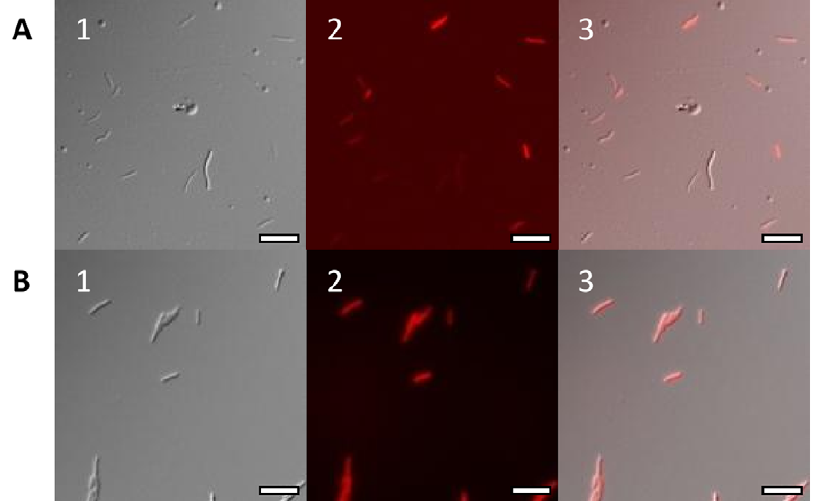
Figure 4. Microscopy of M.smegmatis mc 2 155 strains expressing mCherry. M. smegmatis transformants were grown in liquid for microscopy. Cells were visualised by differential interference contrast and fluorescence microscopy. Panel A - transformants carrying P hsp60 -mCherry. Panel B - transformants carrying P smyc -mCherry. 1 - Differential interference contrast; 2 - Texas Red filter; 3 - overlaid image. Scale bar is equal to 10 m m.